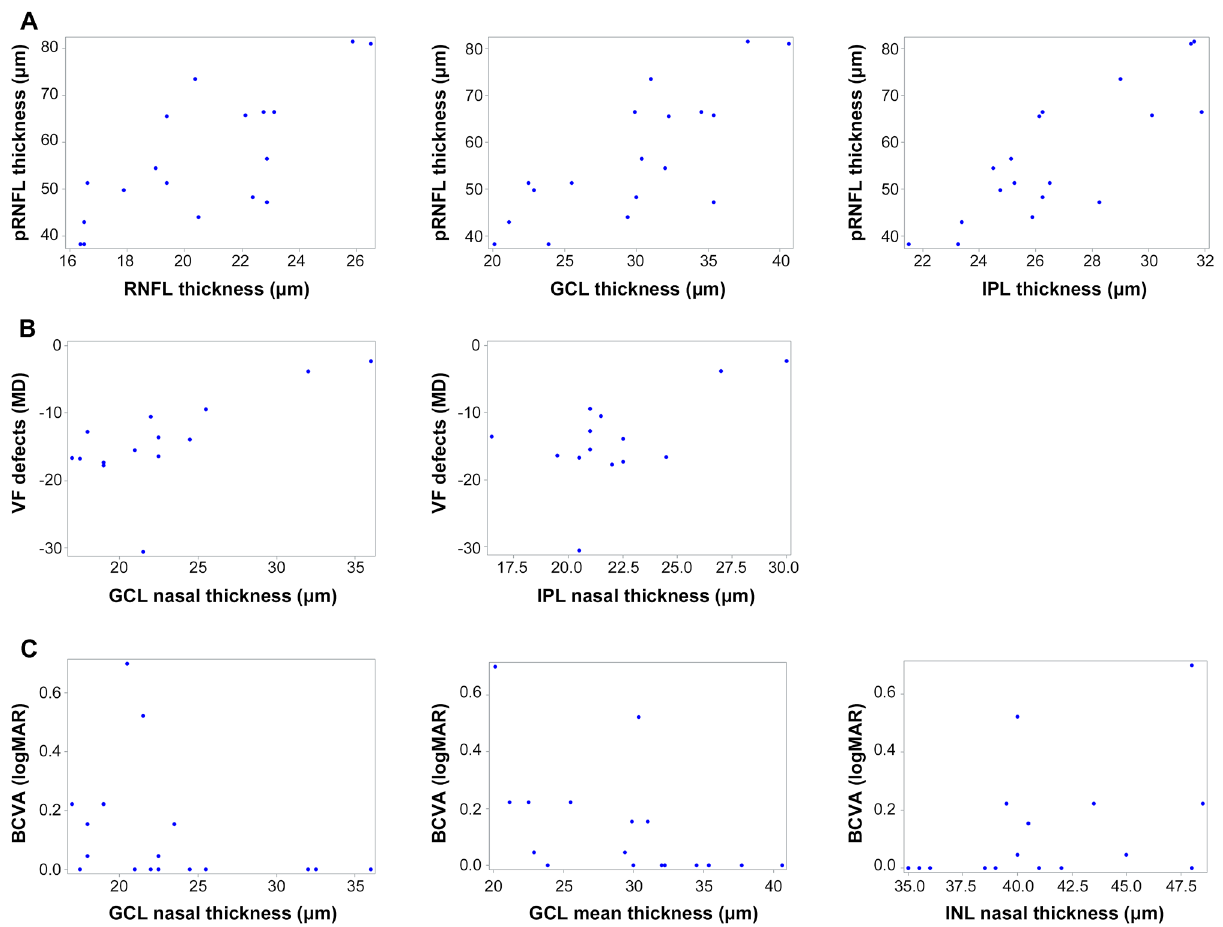
Figure 1. Scatter plots show the association between postoperative intra-retinal layer thickness and other ocular parameters including peripapillary retinal nerve fiber layer thickness (pRNFL), visual field (VF) defects, and best-corrected visual acuity (BCVA). The associations between ( A ) postoperative pRNFL thickness and the macular RNFL ( r = 0.7450, p = 0.0004), GCL ( r = 0.7739, p = 0.0002), and IPL ( r = 0.8257, p < 0.0001) are presented. ( B ) Postoperative VF defects were associated with nasal quadrant GCL ( r = 0.6806, p = 0.0074) and IPL ( r = 0.5662, p = 0.0348) thickness, and ( C ) the postoperative BCVA was associated with the average value of GCL and nasal quadrant GCL ( r = − 0.7162, p = 0.0008; r = − 0.5413, p = 0.0203) and INL ( r = 0.4962, p = 0.0362)